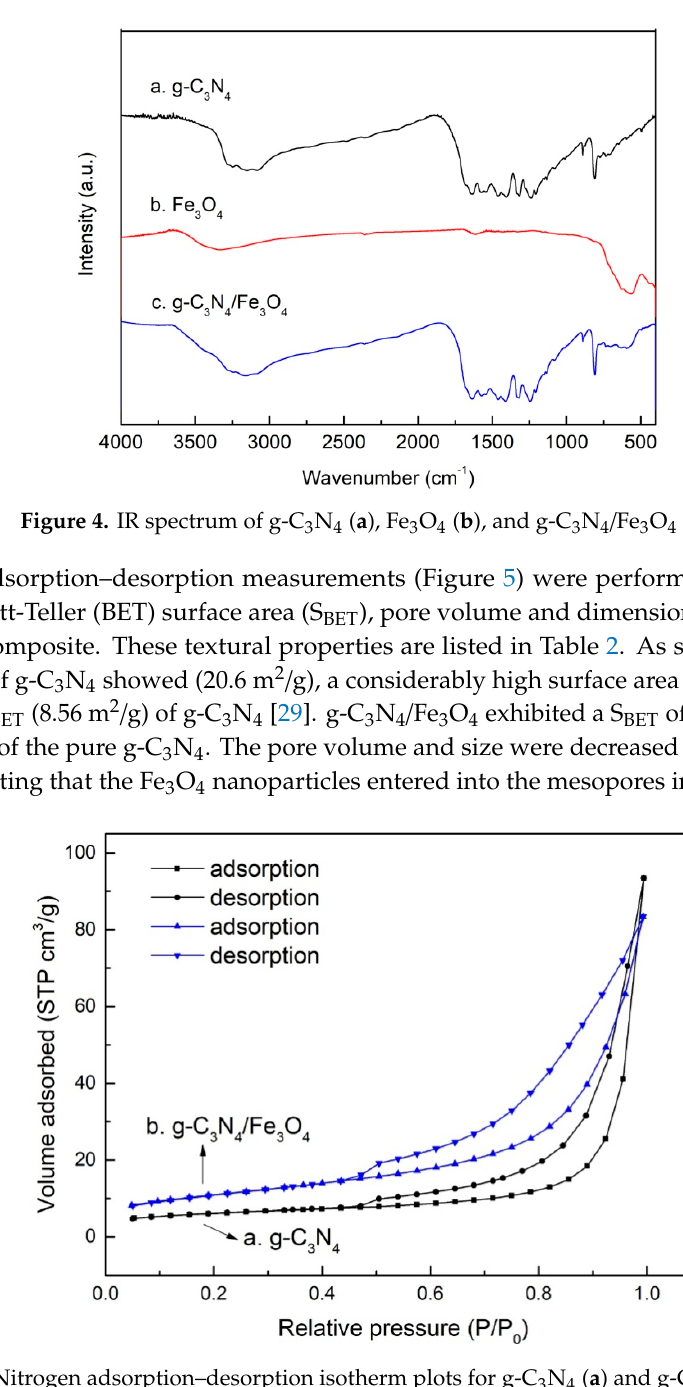
Figure 5. Nitrogen adsorption–desorption isotherm plots for g-C 3 N 4 ( a ) and g-C 3 N 4 / Fe 3 O 4 ( b ). Table 2. Textural properties of g-C 3 N 4 and the g-C 3 N 4 / Fe 3 O 4 composite.